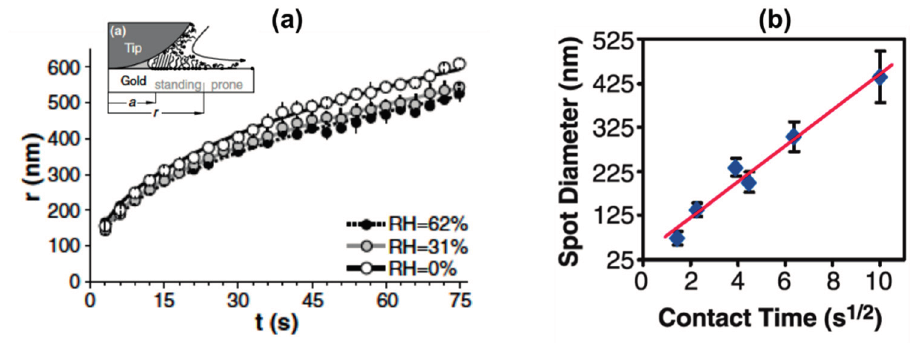
Figure 20. Using DPN, ( a ) The spot size of hydrophobic alkanethiol molecules obtained with the contact time on gold substrate at various relative humidity conditions (reprinted with permission from [114]); ( b ) The spot sizes obtained for DNA molecules on gold substrate. Reprinted with permission from [34]. The spreading regime was characterized with a behavior of spot radius r ~ t 1/2 .